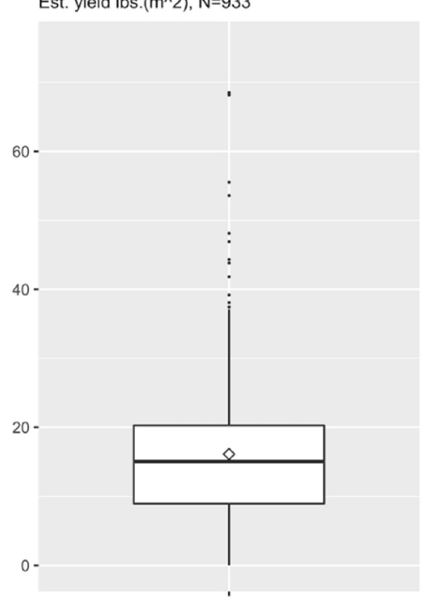
Figure 4. Yield estimates in lbs. per square meter.